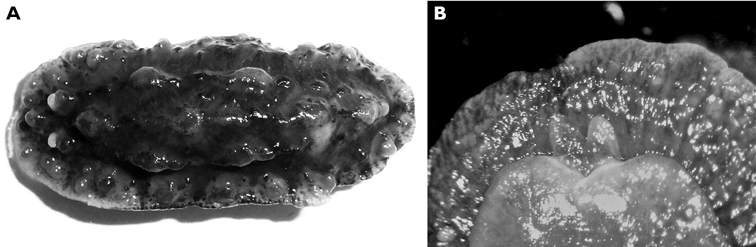
Fryeria picta, 27 mm pres. specimen A dorsal view B ventral view of propodium, head, and tentacles.